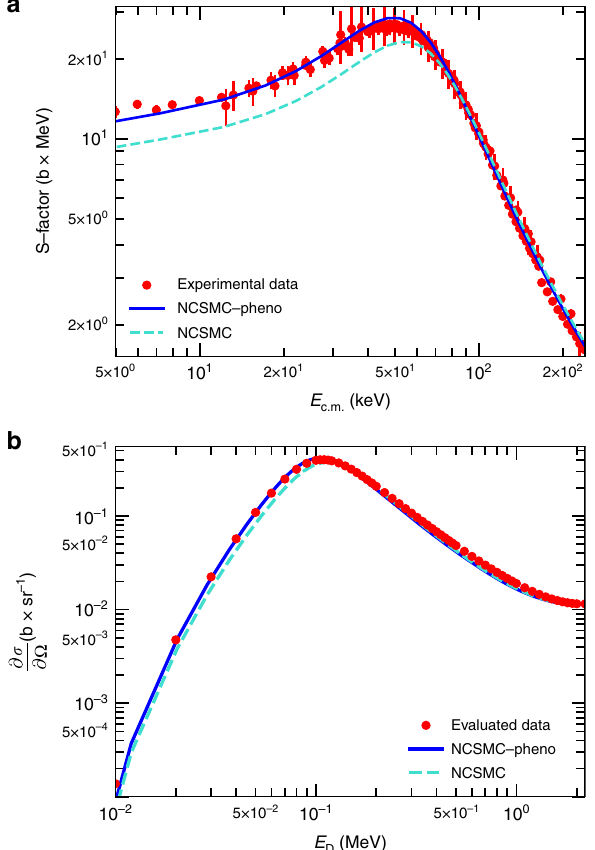
Fig. 1 Unpolarized DT cross sections. a Astrophysical S-factor as a function of the energy in the center-of-mass (c.m.) frame, E c.m. , compared to available experimental data 21 – 25 (with error bars indicating the associated statistical uncertainties). b Angular differential cross section ∂ σ ∂ Ω function of the deuterium incident energy, E D , at the c.m. scattering angle of θ = 0° compared to the evaluated data of ref. 26 . In the fi gures c.m. “ NCSMC ” and “ NCSMC-pheno ” stand for the results of the present calculations before and after a phenomenological correction of − 5 keV to the position of the 3/2 +